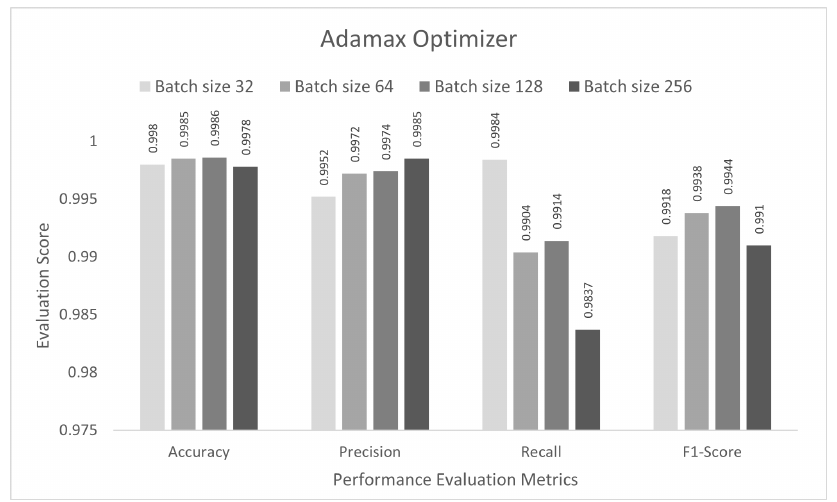
Figure 5. AdaMax optimizer for binary class